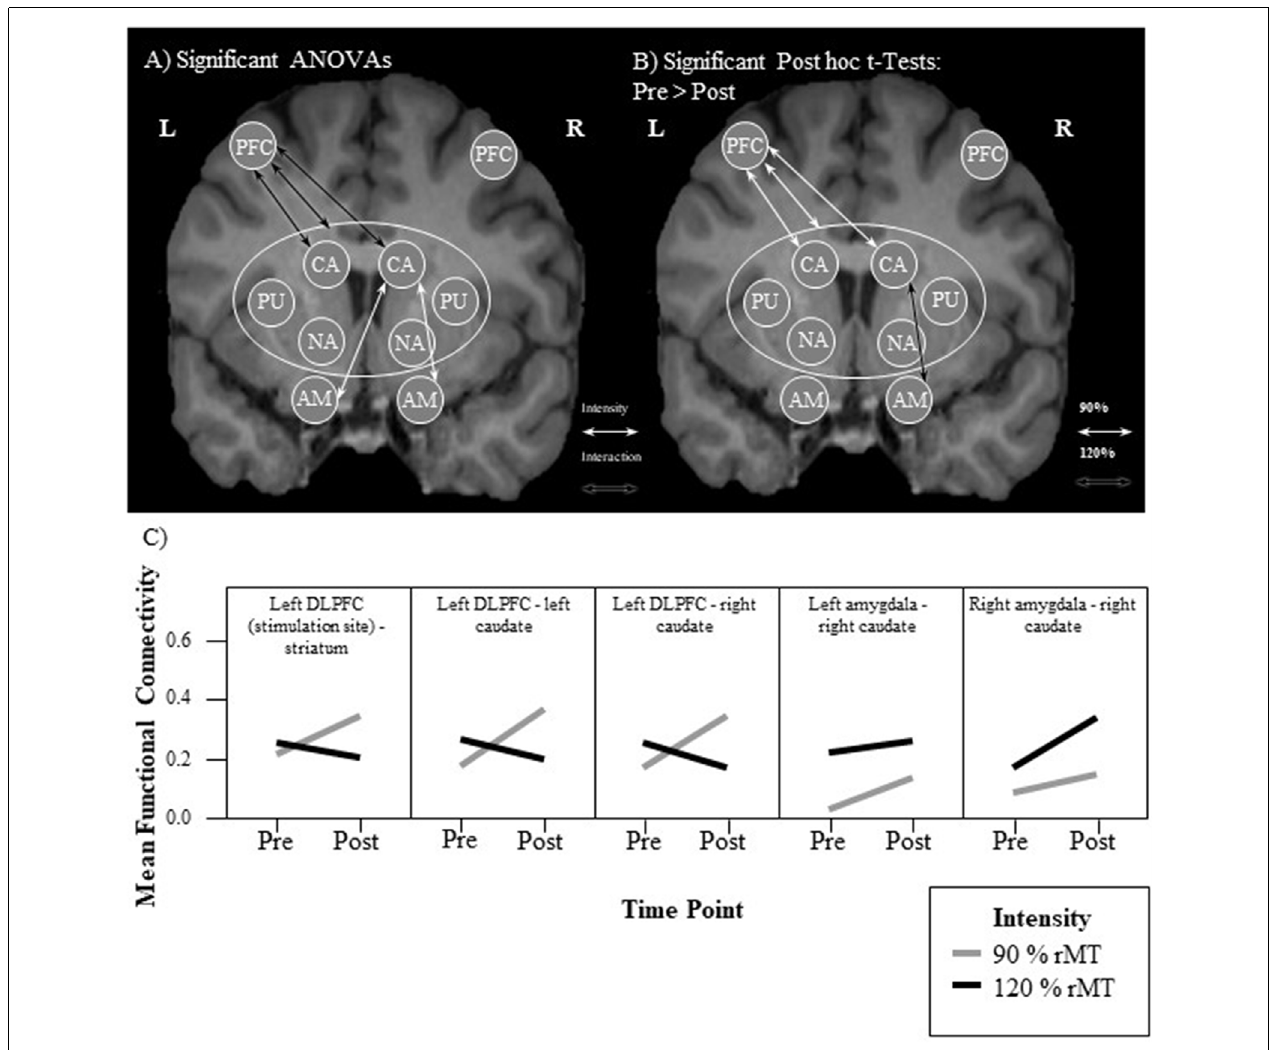
FIGURE 2 | Visualization of results. (A,B) Each arrow represents a significant test result. Significant analysis of variance (ANOVA) effects are shown in (A) and significant paired t -tests in (B) . It can be seen that functional connectivity between the left prefrontal cortex (PFC; stimulation site) and the left and right caudate, respectively, as well as between the right caudate and the left and right amygdala, respectively, was modulated by the experimental stimulation. (A) White arrows indicate a significant intensity effect and black arrows a significant interaction effect. White ellipses indicate a seed region of interest. (B) Only pre-post transcranial magnetic stimulation (TMS) comparisons were calculated. All significant changes were increases from pre to post. Functional connectivity increased significantly only in the 90% condition between the stimulation site and the striatum. Analyzing the functional connectivity patterns between the stimulation site and each of the subregions of the striatum revealed that only the increase in functional connectivity between the stimulation site and the right and left caudate, respectively was significant. Additionally, functional connectivity between the right amygdala and the right caudate was increased only in the 120% condition. (C) Mean functional connectivity results. Shown are mean Fisher-Z-transformed correlations for the significant ANOVAs of functional connectivity between seeds, in the four different conditions 90% pre and post (gray line) and 120% pre and post (black line) measurements. Positive values indicate a positive coupling of signals between the two seeds. The first graph visualizes results between the stimulation site (left DLFC) and the entire striatum [consisting of left and right caudate (CA), left and right nucleus accumbens (NA), as well as left and right putamen (PU)]. AM,